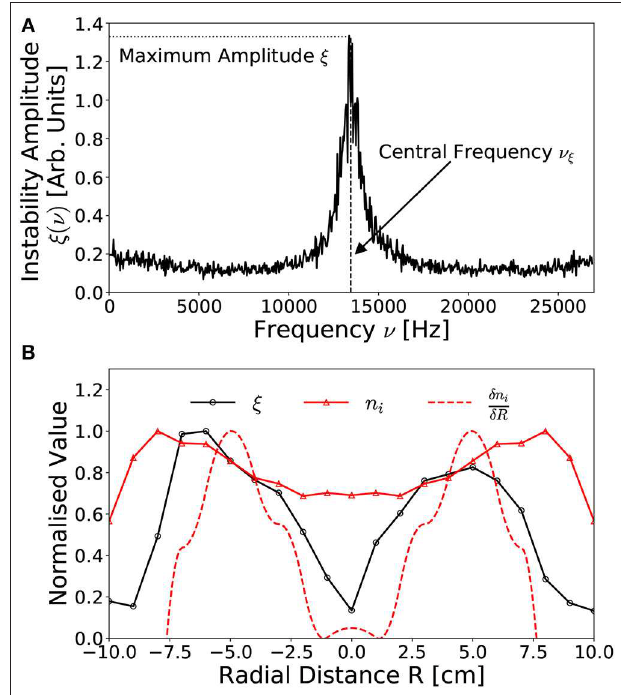
FIGURE 2 | Representative examples of (A) the fourier transformed ion saturation current measured off-axis (R, Z = –6 cm, 2 cm) downstream of the DL, exhibiting an anomalous instability centered on ν ξ = 13.4 kHz with a 2 kHz FWHM bandwidth and (B) the radial distribution (at Z = 2 cm) in the maximum instability amplitude ξ , the ion density n i and the radial ion density gradient δ n i δ . Solid lines added to guide the eye. Operating conditions: helicon R antenna supplied P rf = 300 W at ν rf = 13.56 MHz employing 0.25–0.30 mTorr argon with I 1,2 = 6 A solenoid